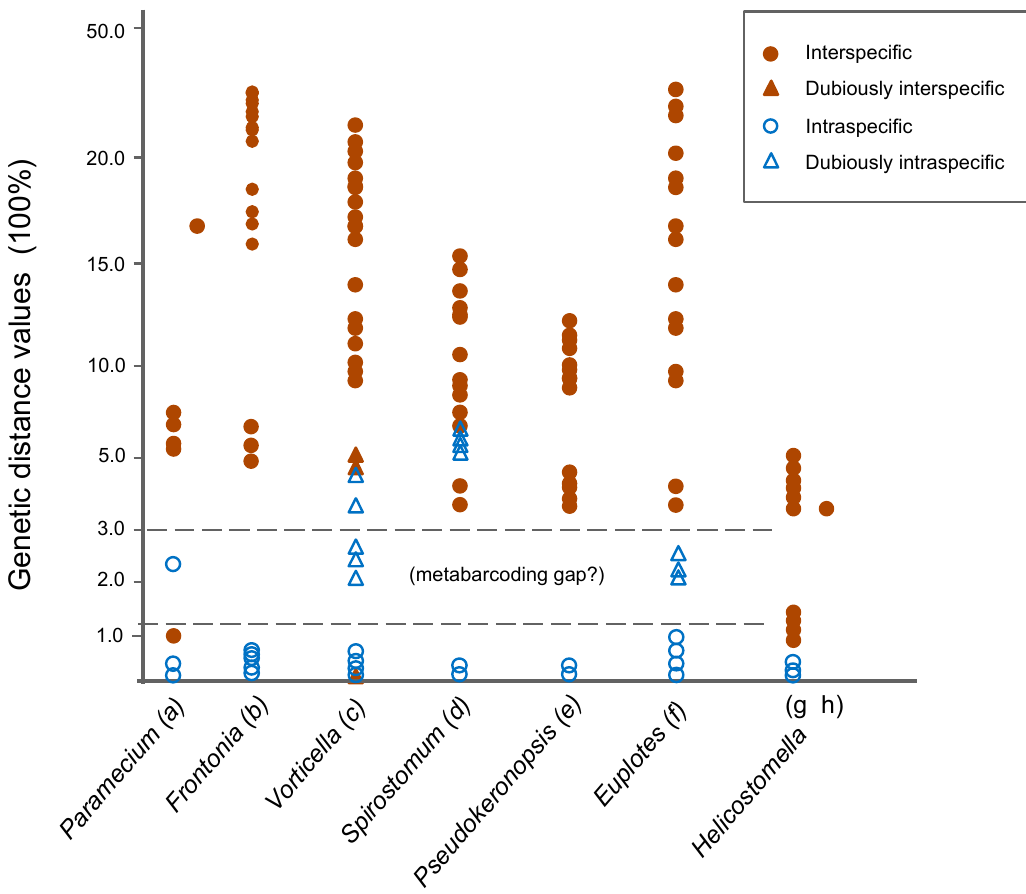
Figure 9. Genetic distances of ITS1-5.8S-ITS2 from the previous and present studies. Data were obtained from or calculated on the basis of the database of ( a ) [25], ( b ) [14], ( c ) [31], ( d ) [30], ( e ) present study, ( f ) [15], ( g ) [60] and ( h ) [33].